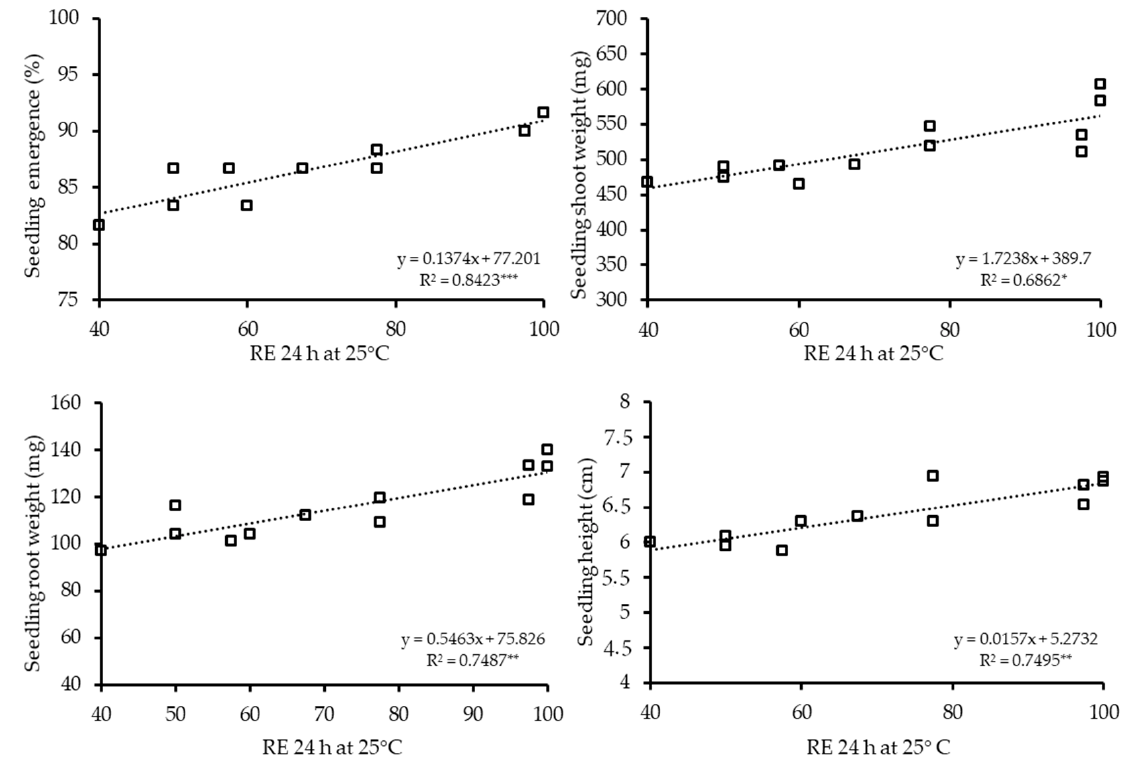
Figure 6. The relationship between RE 24 h at 25 °C and seedling emergence (%), seedling shoot weight (mg), seedling root weight (mg) and seedling height (cm) of 12 hybrid cucumber seed lots at low temperature and salt stress combinations. Values were derived from Table 4. * p < 0.05, ** p < 0.01, *** p < 0.001. Table 4. Variation in seedling emergence (SE, %), seedling shoot weight (SSW, mg), seedling root weight (SRW, mg) and seedling height (SH, cm) at low temperature and salt stress combination. Means with different letters are significant at the 5% level in each column.